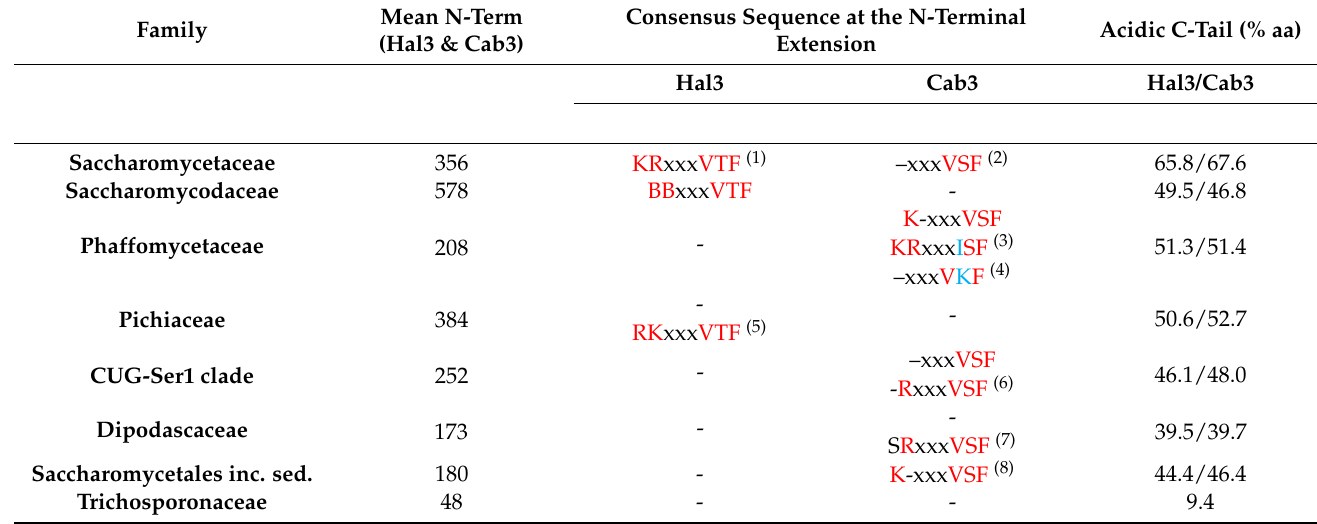
Table 1. Structural features of the Hal3/Cab3 N- and C-terminal extensions in the Saccharomycotina subphylum. “B” denotes basic amino acids. Functionally relevant residues (as defined in [42]) are shown in red and specific variants in light blue. Calculations for size and compositions were conducted as shown in Figure